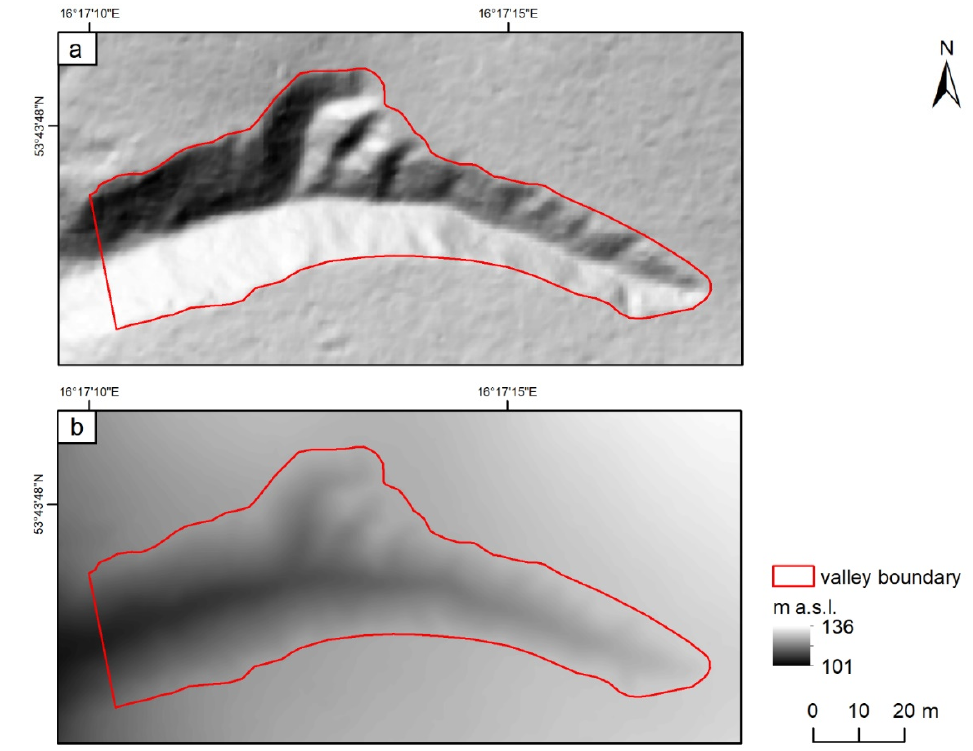
Figure 5. Example of the boundary of the concave landform: ( a ) Hillshade map of the valley; ( b ) DEM of the valley based on the LiDAR data.